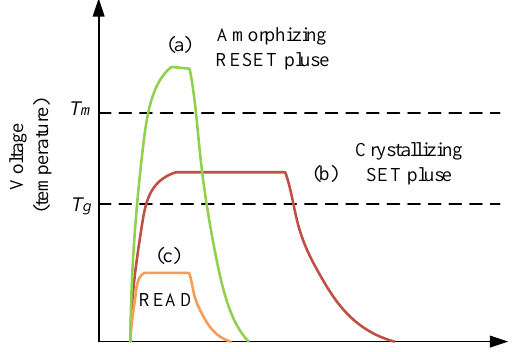
Figure 2. An illustration of RESET, SET and READ programming pulses.